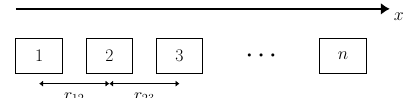
Figure 1. Sketch of the model with n coplanar faults. The x axis is the strike direction. Distances r ij between the i th and j th faults are computed from the fault